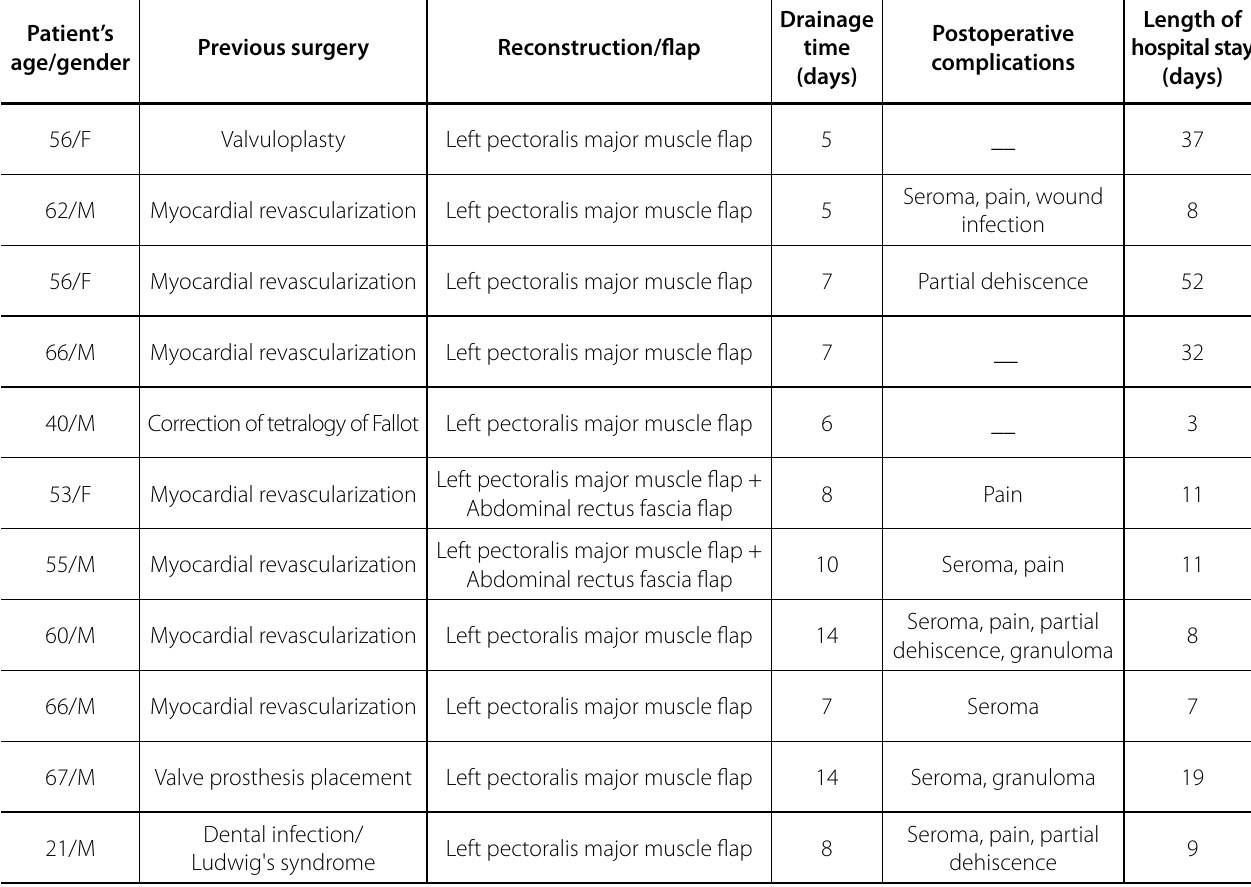
Table 1. Data from the patients who underwent sternal wound closure using unilateral pectoralis major muscle flap.